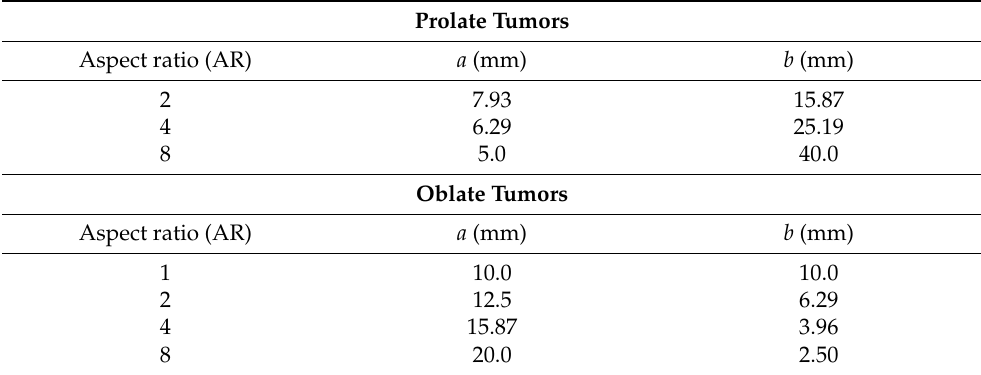
Figure 1. ( a ) Virtual representation of tumors by ellipsoid geometries. ( b ) Notation of the major and minor axis length of the spheroids. All shapes shown have the same volume and are fully symmetric around the y -axis. Table 1. Dimensions of the ellipsoidal tumors